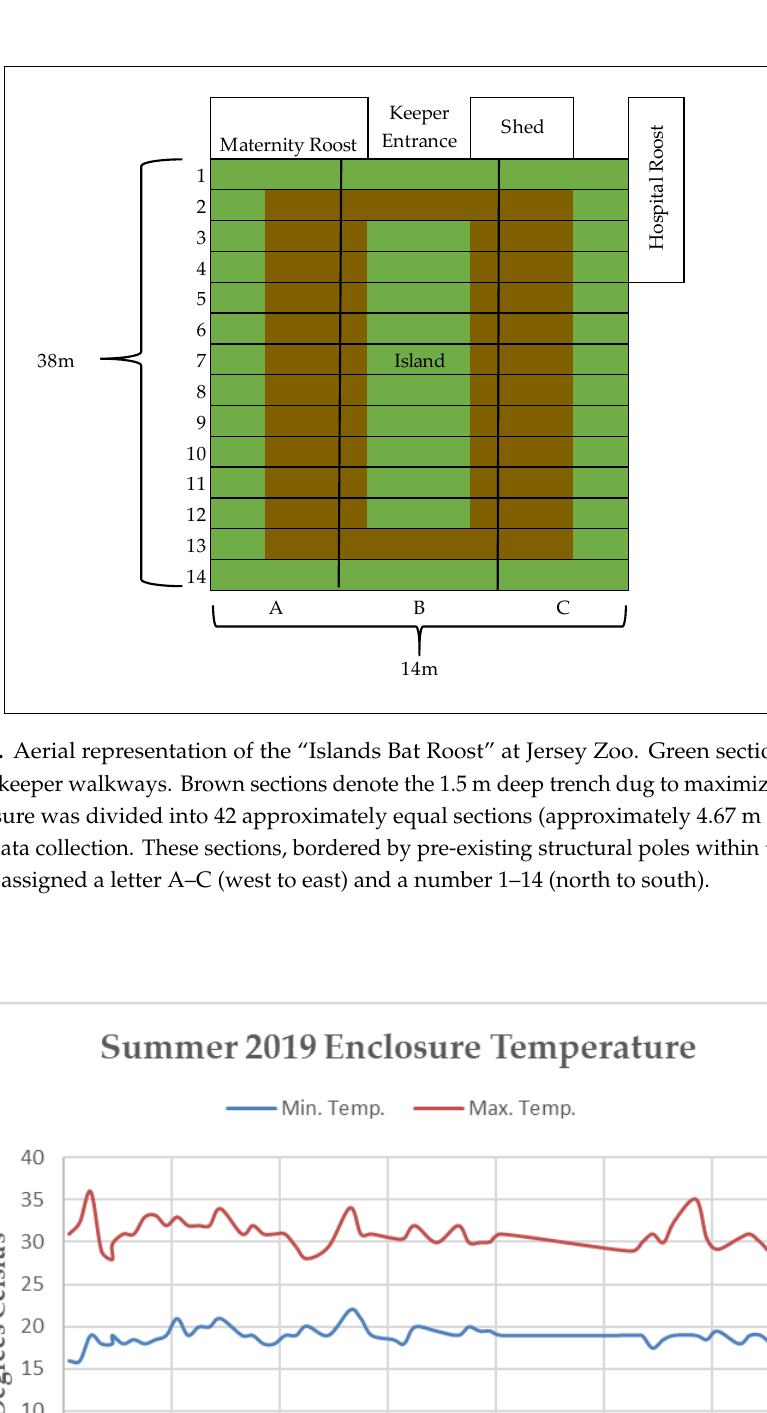
Figure A2: Line graph of the minimum and maximum average temperatures reported by the internal temperature monitoring system of the “Island Bat Roost” at Jersey Zoo between June and September of 2019. Dates listed are ten days apart. Tick marks along the x-axis denote one day.